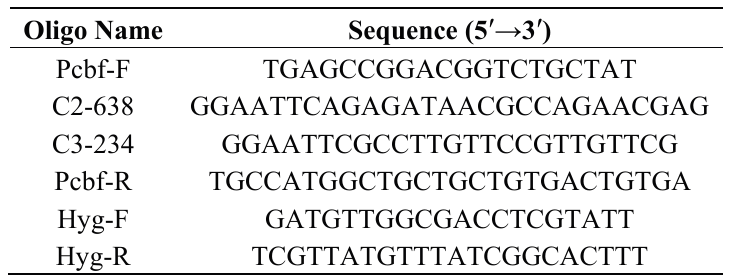
Table 1. Primers used for